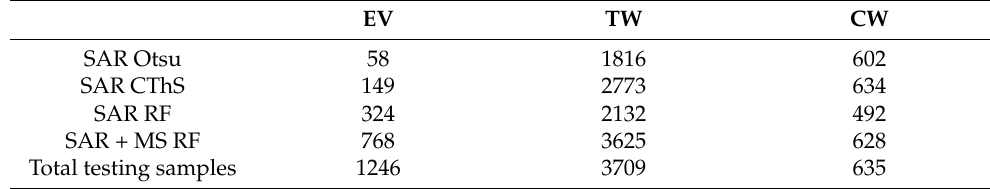
Table 4. Otsu and CThS classifiers: number of pixels lumped in the water class, disaggregated into emergent vegetation (EV), turbid water (TW), and clear water (CW) according to the testing dataset. Number of pixels classified as EV, TW, and CW by the SAR RF and SAR + MS RF classifiers and actual number of EV, TW, and CW pixels according to the testing dataset.